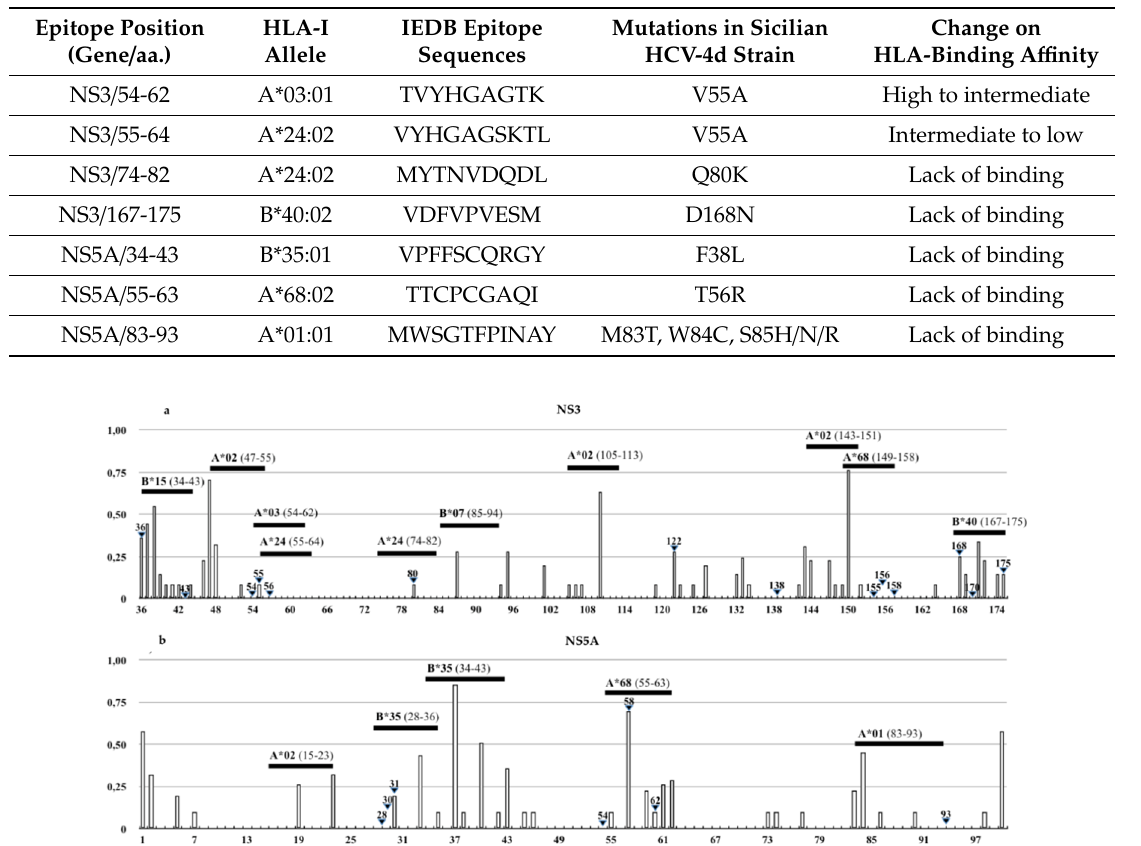
Table 3. Impact of RASs (bold) and amino acid polymorphisms on HLA-binding a ffi nity evaluated intermediate a ffi nity, values < 5000 nM were considered low a ffi nity, and values > 5000 nM were considered to have caused a lack of binding.